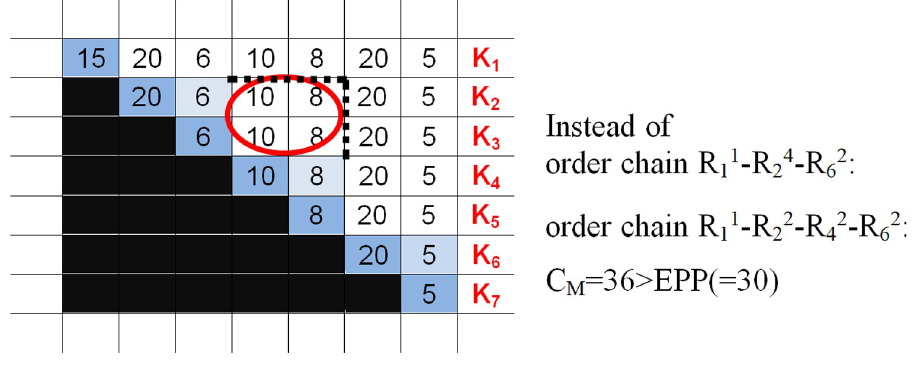
Fig 5. Cost savings (and reasonability) of the EPP triangle